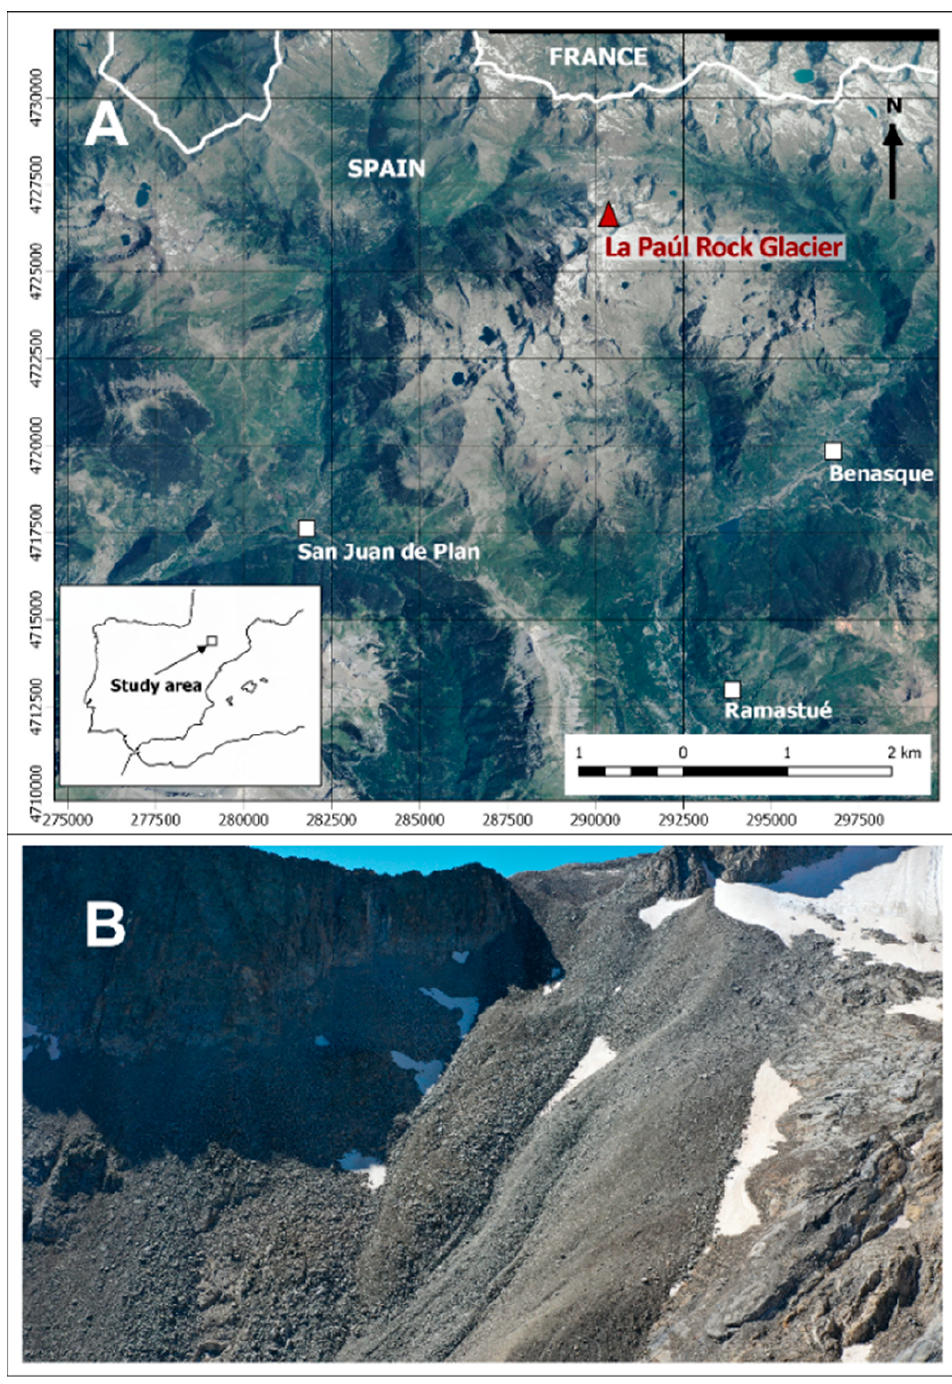
Figure 1. Study site. ( A ) Rock glacier location (EPSG: 25831). ( B ) Rock glacier and surroundings image in 2019.